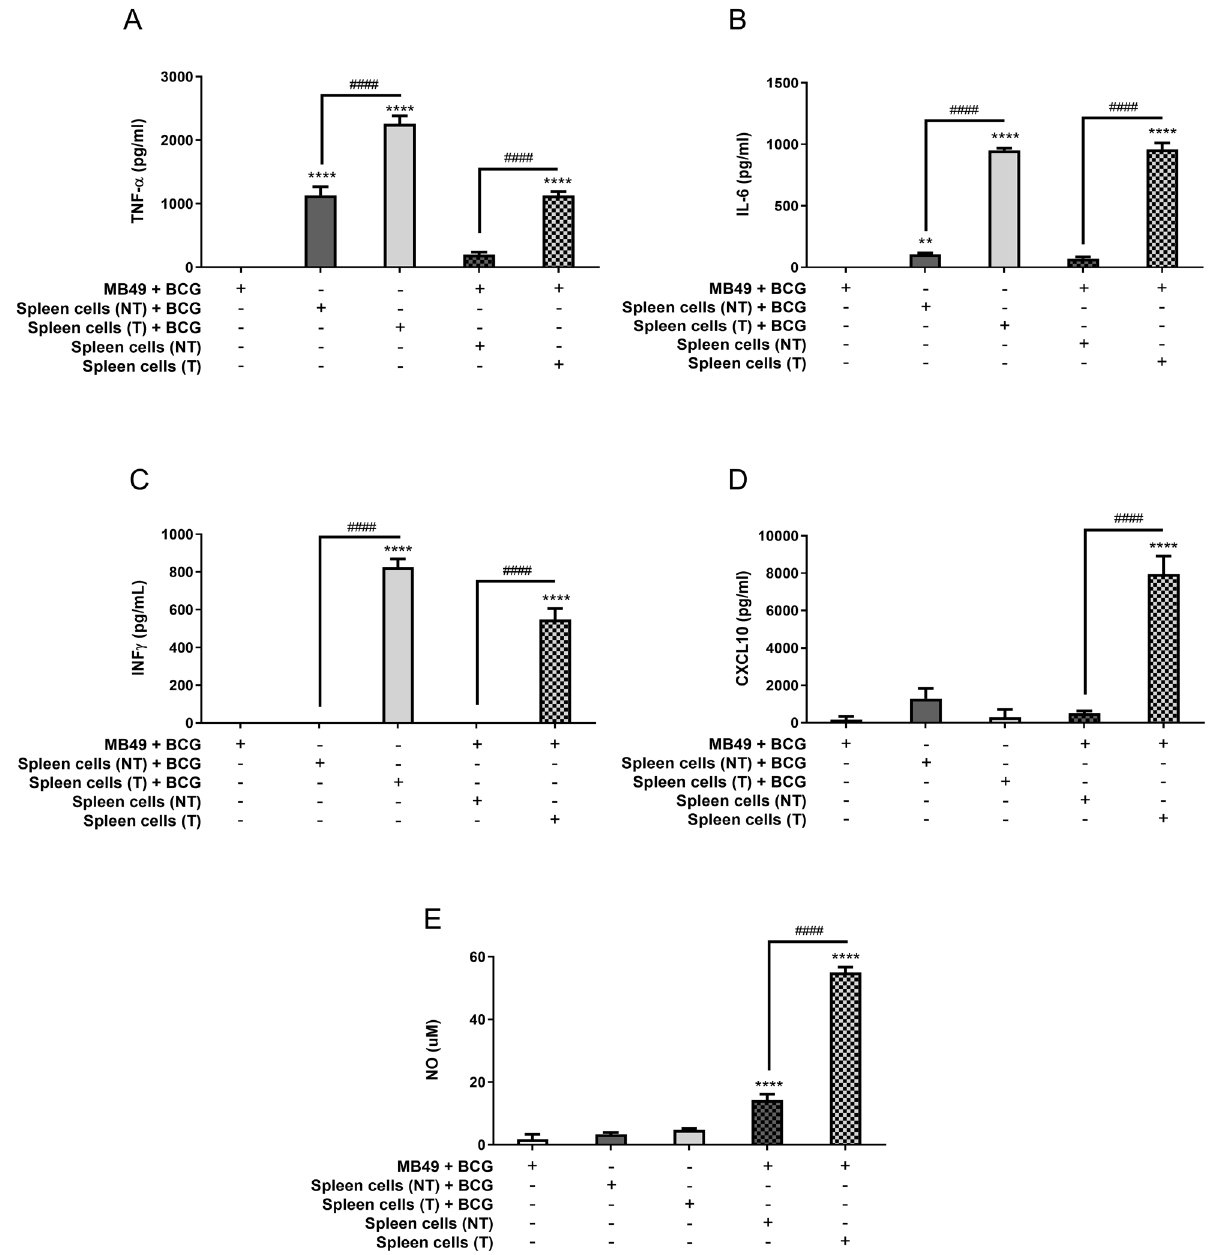
Figure 3. Spleen cells from animals treated with BCG are strongly activated in co-culture with infected MB49 cells. Spleen cells were obtained from mice submitted to the subcutaneous tumor model and treated with BCG (T) or control PBS (not treated—NT) (as shown in Fig. 1A) and euthanized at day 22 post-tumor injection. Splenocytes suspension was used for co-culture in vitro with infected MB49 cells (1 MB49 cell: 2 spleen cells). MB49 cells used for co-culture were previously infected with BCG (MB49 + BCG) for 24 h and washed to remove free BCG in the supernatant. Co-cultured cells were maintained together for 24 h ( A – D ) or 48 h ( E ), when the samples were collected for analysis. MB49 or splenocytes were also infected separately (not in co-culture) and used as controls. Measurement of TNF-α ( A ), IL-6 ( B ), IFN-γ ( C ) and CXCL10 ( D ) production in the supernatants after 24 h was performed by ELISA. ( E ) NO production was evaluated by the Griess method in supernatants after 48 h of stimulation. The values are representative of at least three independent experiments. *Statistically significant compared to MB49 + BCG, ** P ≤ 0.01, **** P ≤ 0.0001. # Statistically significant data comparing treated (T) and not treated (NT), #### P <